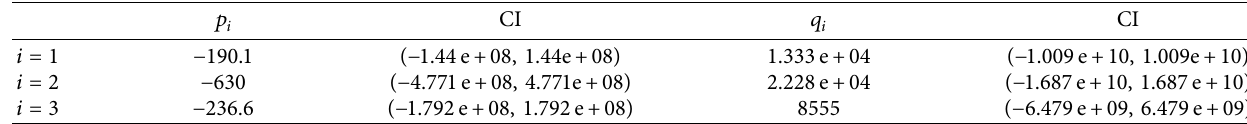
Table 12: HoF vs. J.